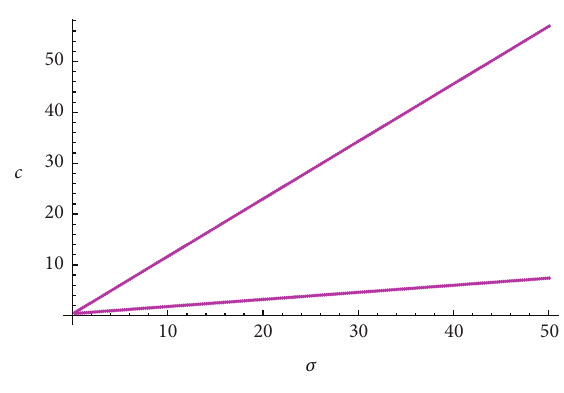
Figure 2: H2 points in the parameter plane (𝜎,𝑐) for system (59) ( 𝑏 2 = −1